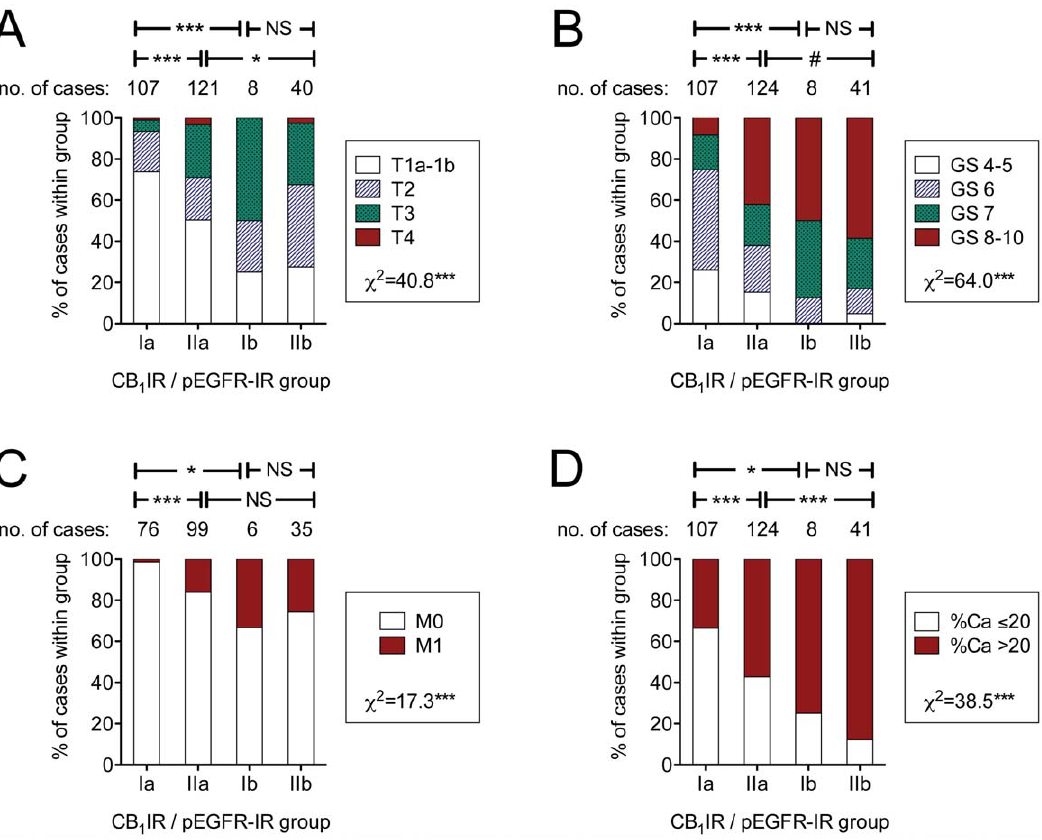
Figure 4. Effects of the tumour CB 1 IR and pEGFR scores upon the severity of the disease at diagnosis. Shown are: A, tumour stage (T); B, Gleason scores (GS); C, absence (M0) or presence (M1) of metastases at diagnosis; and D, the % of the specimen that was contained tumour (%Ca). For definition of the CB 1 IR/pEGFR-IR groups, see Legend to Fig. 3. The x 2 statistic for the total data set is given in each panel under the explanatory legends. The symbols between the capped lines above the bars indicate significance levels for the individual comparisons shown. ***p , 0.001, # p , 0.1, NS, p . 0.2, x 2 test or Fisher’s exact test (when comparisons were for a 2 6 2 matrix).